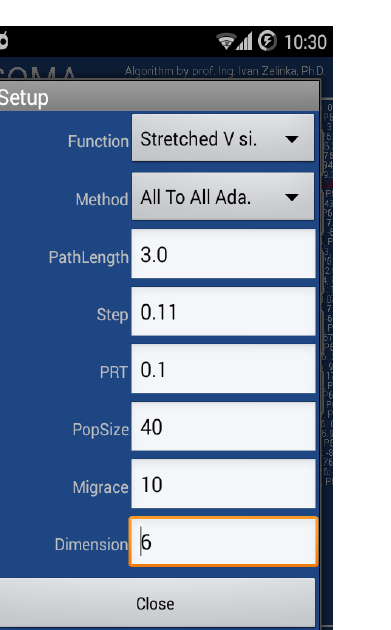
Fig. 2: App AI SOMA Source: Custom processing (cid:21) app screenshot